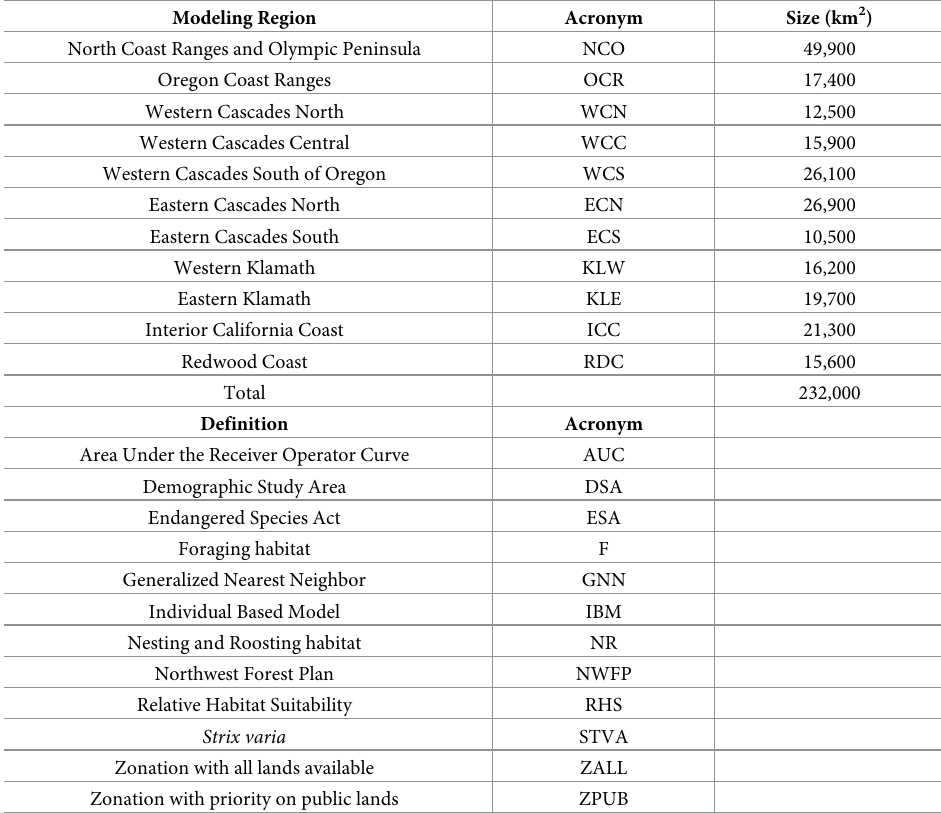
Table 1. Name, acronym and size of modeling regions, and definitions of acronyms used